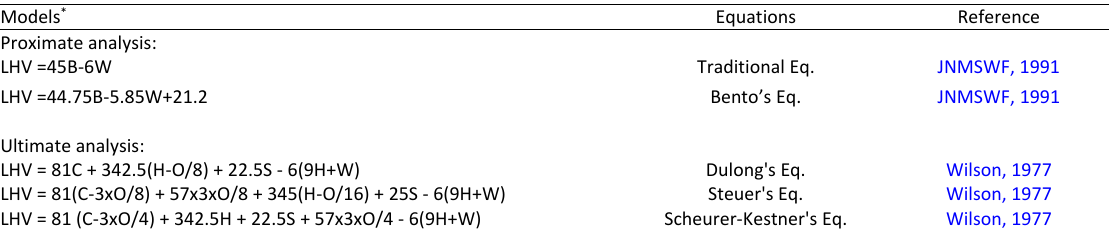
Table 1: Heat value models based on physical, proximate and ultimate analyses Models *